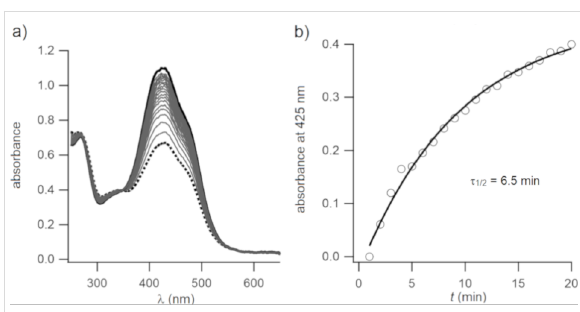
Figure 3: a) UV–vis spectra of 4 in DCM (ca. 15 µM) at the PSS and 440 nm irradiation (thick dotted line; ca. 60% Z -isomer), and during thermal reversion to the dark-adapted state (solid black line). b) Time course of thermal reversion at 22 °C. Data were fitted to a single expo- nential decay equation (solid